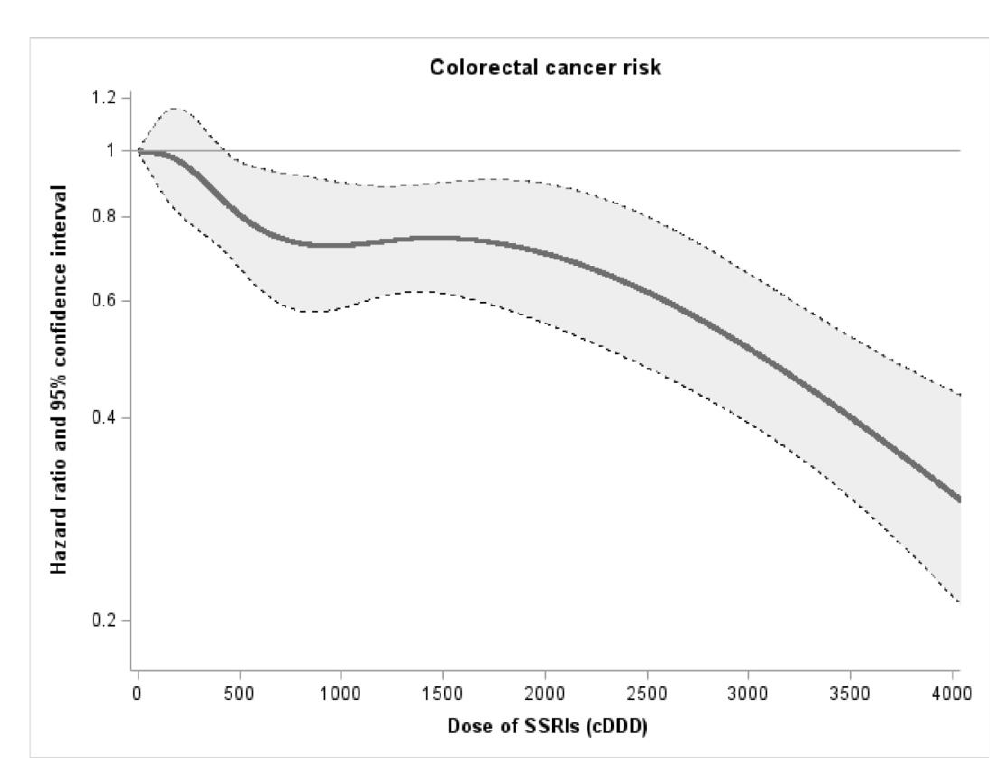
Figure 2. Association between different doses of SSRI use and the risk of colorectal cancer using restricted cubic spline, with 95% confidence intervals (the gray area). Adjusted for age at index, sex, education, birth country, income, history of inflammatory bowel disease, COPD, obesity, outpatient visits, history of colonoscopy, use of aspirin, use of statin, use of metformin, CCI. Findings from stratified analyses are listed in Table 3. The association between SSRI use and CRC risk was significant among adults aged 60 to 69 years (adjusted HR, 0.61, 95% CI, 0.51 – 73) but not among adults aged 50 to 59 years (adjusted HR, 0.91; 95% CI, 0.76 – 1.09) and adults aged 70 years or older (adjusted HR, 0.86; 95% CI, 0.73 – 1.01). As stratified by gender, women may benefit more from using SSRIs (adjusted HR, 0.74; 95% CI, 0.64 – 0.84) when compared with men (adjusted HR, 0.84; 95% CI, 0.72 – 0.97). Table 3. Hazard ratios and 95% confidence intervals of different types of colorectal cancer associated with SSRI use among individuals with a family history of CRC, stratified by age and sex. Individuals, n